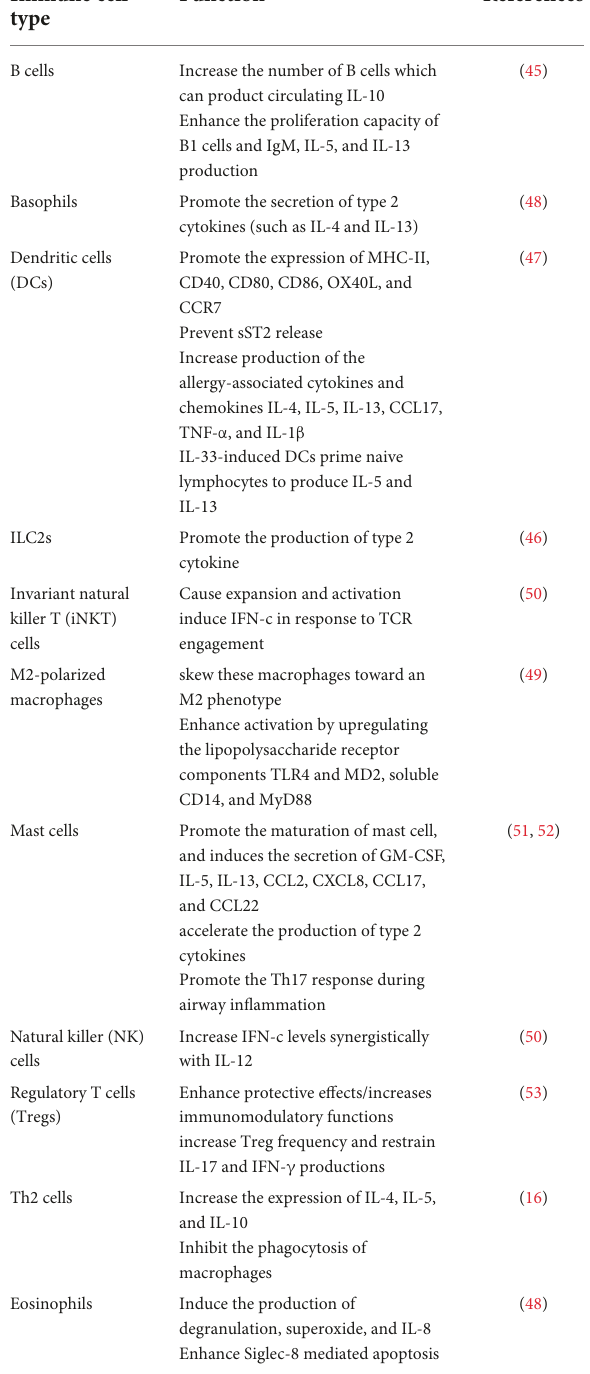
TABLE 2 Principal immune cells that response to